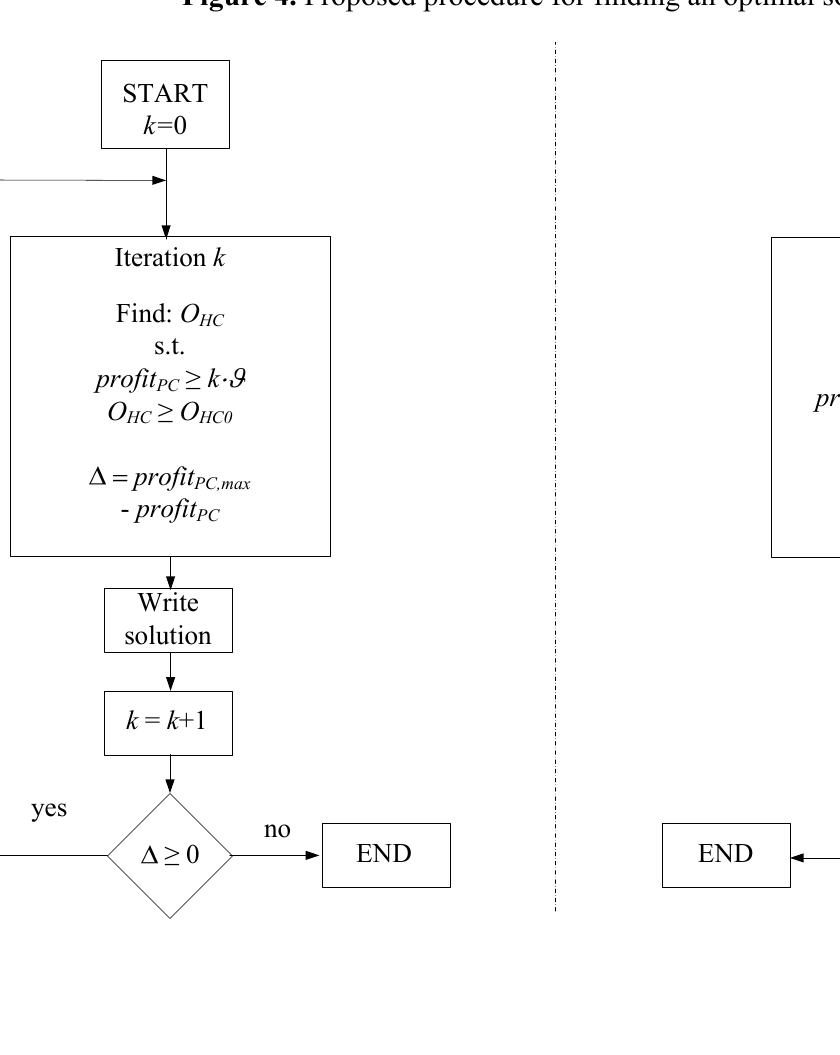
Figure 4. Proposed procedure for finding an optimal